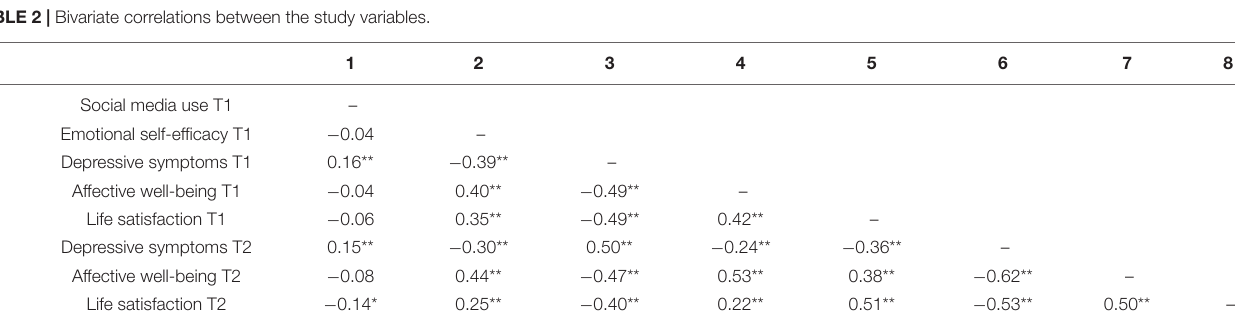
TABLE 2 | Bivariate correlations between the study